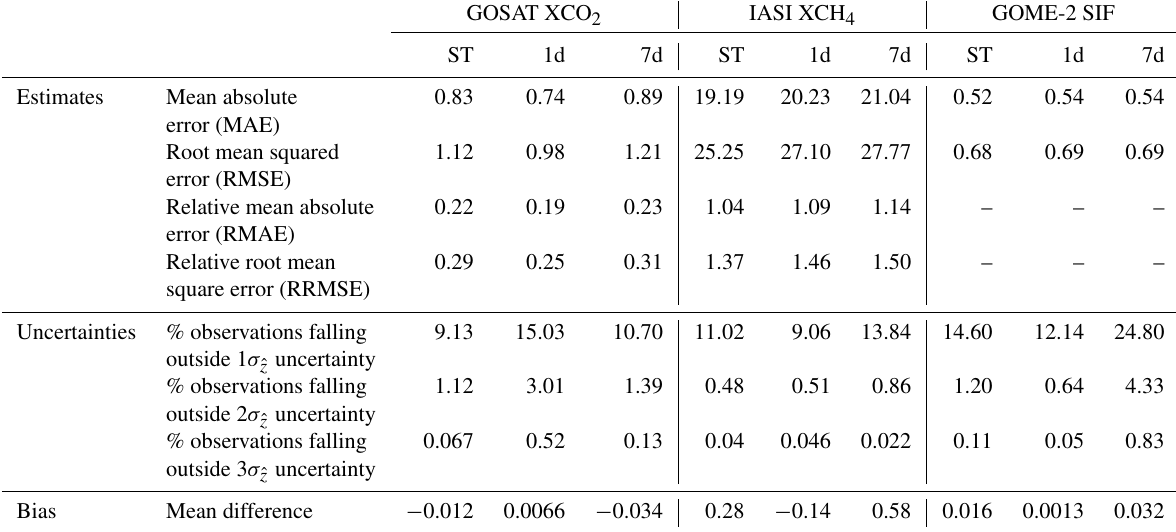
Table 1. Cross-validation results of GOSAT XCO 2 , IASI XCH 4 and GOME-2 SIF datasets using spatio-temporal and spatial methods, including mean absolute error (MAE), root mean squared error (RMSE), relative mean absolute error (RMAE), relative root mean square error (RRMSE), percent of observations lying outside of 1, 2, and 3 standard deviations ( σ ˆ z ) of the mapping uncertainty, and mean difference. The MAE, RMSE and bias units for GOSAT, IASI and GOME-2 are ppm, ppb and mWm − 2 sr − 1 nm − 1 , respectively. RMAE and RRMSE are unitless, and, for the reasons explained in Sect. 4.1, given only for GOSAT and IASI. Shaded fields represent the best estimate in each category for every